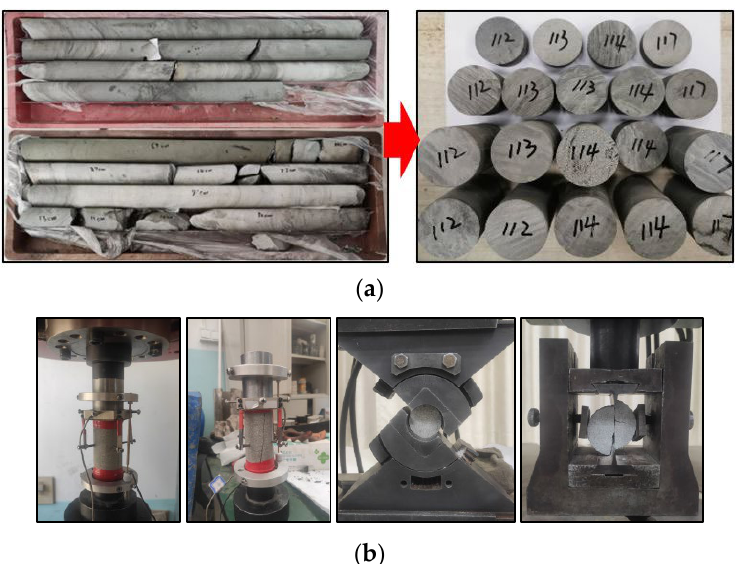
Figure 5. Acquisition of cores and mechanical experiments. ( a ) Cores drilled on site; ( b ) Different experimental procedures. Table 1. Physical and mechanical parameters of rock mass.